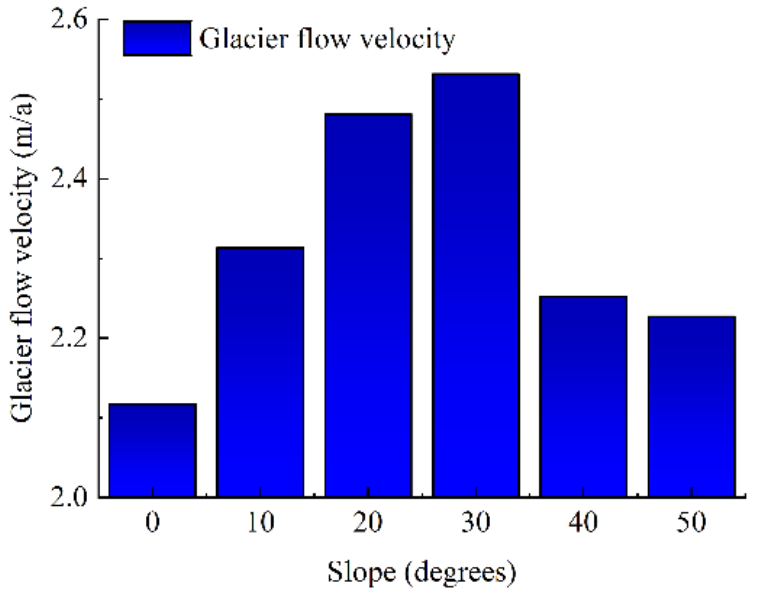
Figure 13. The variation of glacier flow velocity with slope.